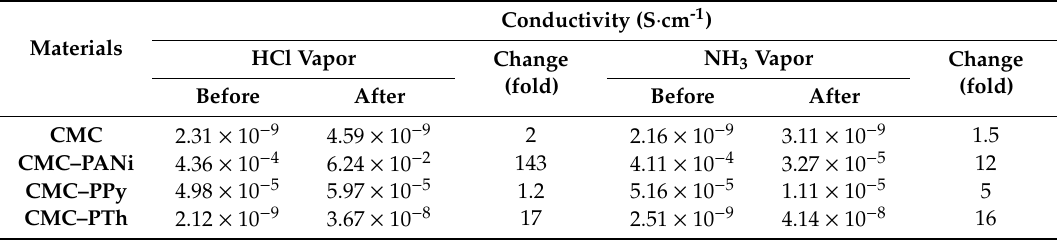
Table 2. The changes in the conductivities of CMC cryogel, CMC–PAN, CMC–PPY, and CMC–PTh cryogel composites after 15 min HCl and NH 3 vapor